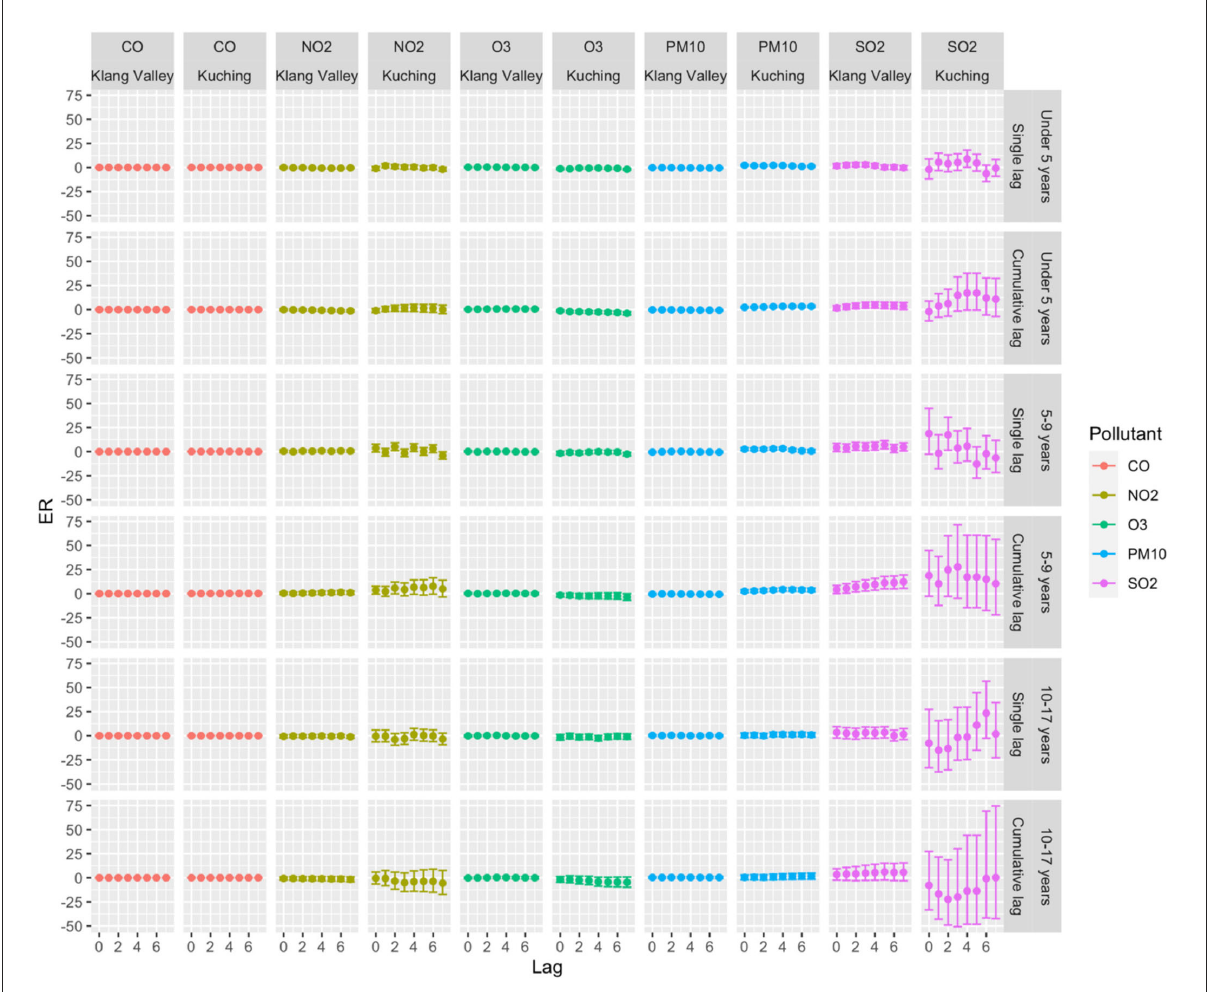
FIGURE8 ER with 95% CI of daily hospital admissions by age group with 10 µ g/m 3 increase of pollutant concentrations in Klang Valley and Kuching for